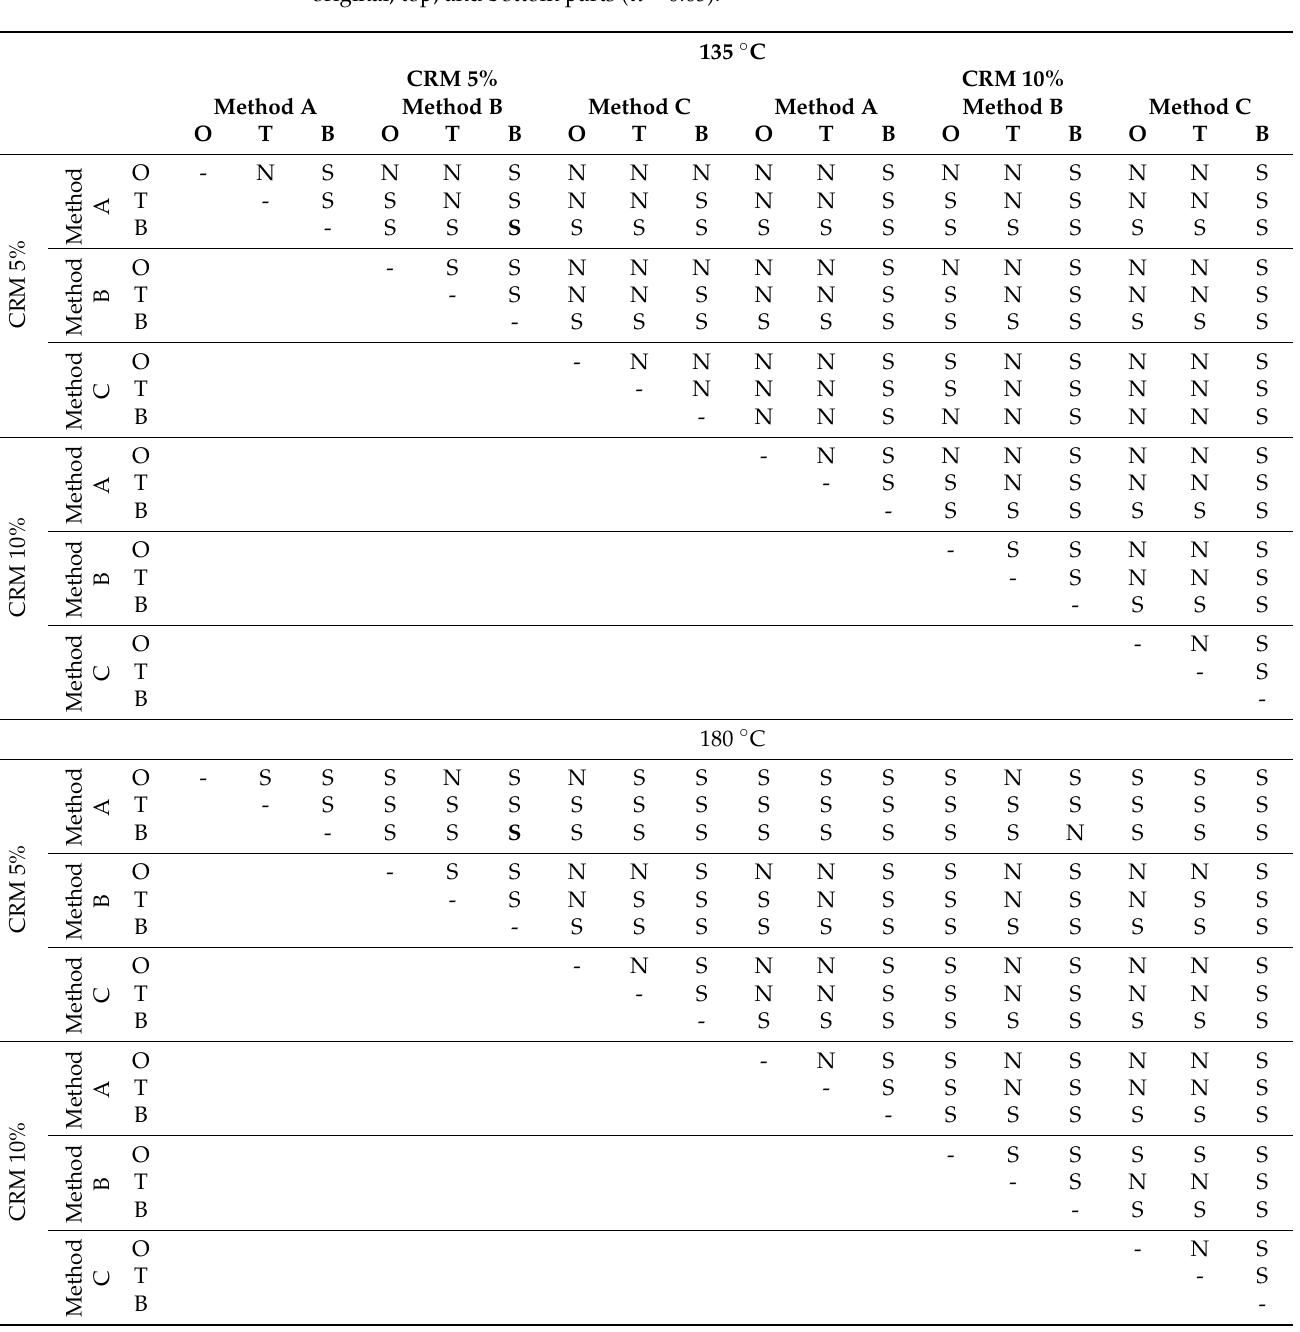
Table 3. Statistical analysis results for the rotational viscosity of the CRM binders as a function of the original, top, and bottom parts ( α =